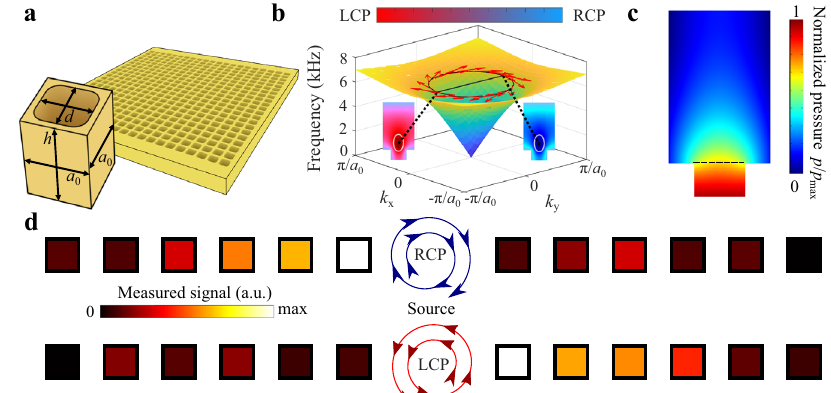
D E , ffiffiffi p 2 ) maps to 0 for a